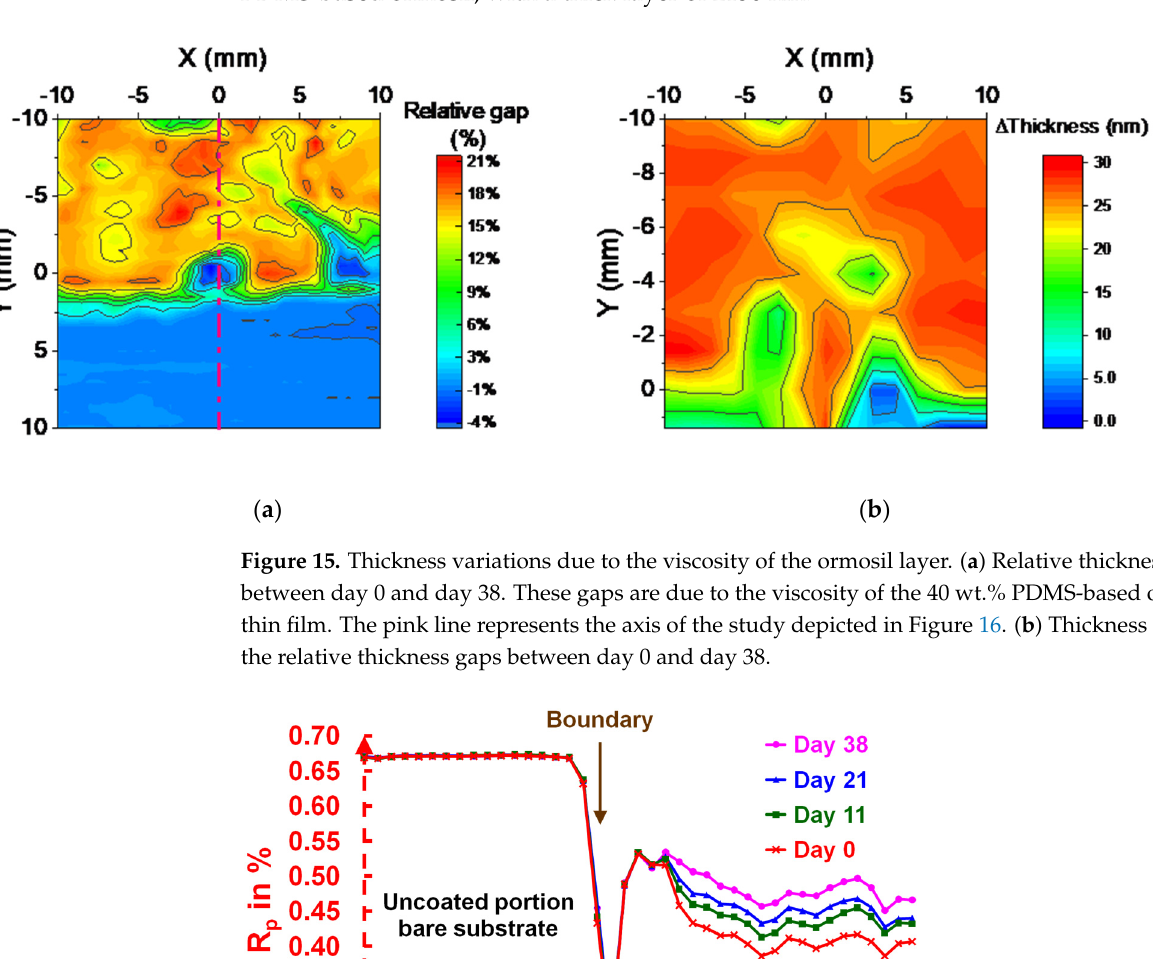
Table 3. Average differences for different days compared to the initial map (2 mm < Y < 10 mm) and associated thickness decreases.